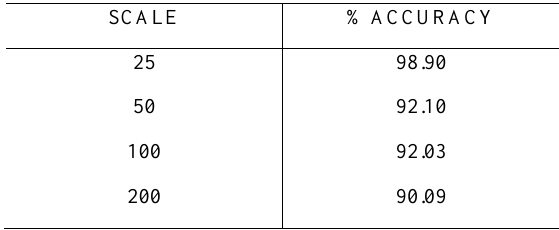
Table 5. Classification accuracies of the four scale parameters